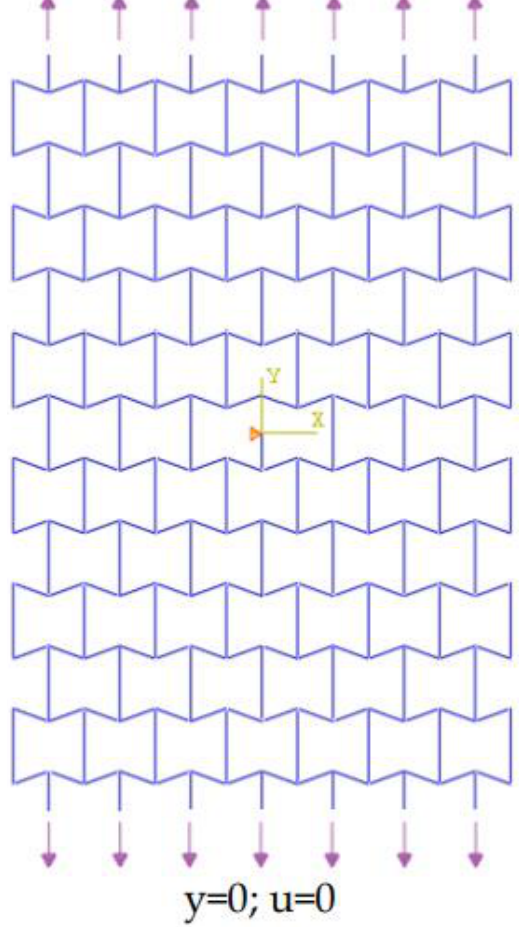
Figure 2. Finite element model and boundary conditions.